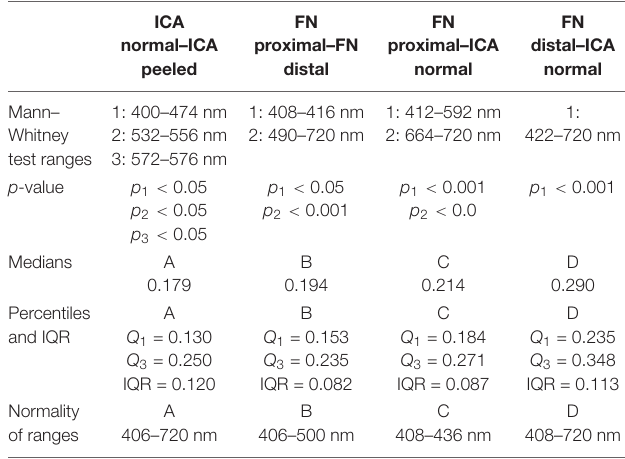
TABLE 1 | Significant wavelength ranges and reflectance characteristics of the tissue